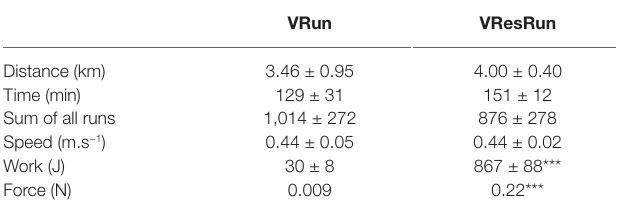
TABLE 1 | Running summary VRun vs. VResRun.